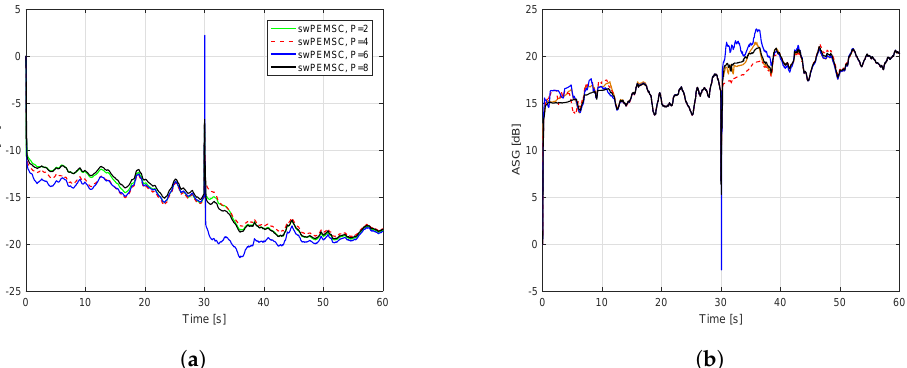
Figure 10. Performance of the proposed method with P ∈ [ 2,4,6,8 ] , music input, feedback path changes from free-field ( F 1 ) to telephone-near ( F 2 ): ( a ) MIS; ( b ) ASG. Experiment 2: This experiment aims at evaluating the performance of the proposed swPEMSC for recorded speech [30] as the incoming signal. The feedback paths depicted in Figure 7 are selected. We suddenly change the feedback path from F 1 to F 2 after 30 s. The performance of the proposed swPEMSC is evaluated in terms of normalised misalignment (MIS), added stable gain (ASG), signal quality (PESQ) and the necessary time ( τ κ Figure 11 compares the performance of the proposed swPEMSC with state-of-the-art baselines such as PEMSC-NLMS, PEMSC-APA (with P = 6) and H-NLMS. It can be